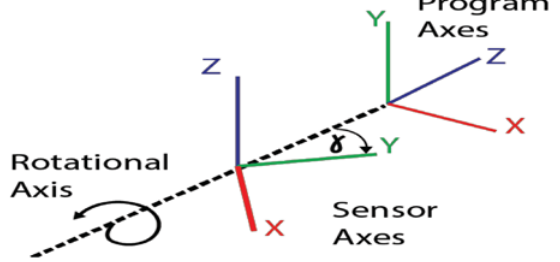
Figure 6. The rotation axis between the attention pose and T-pose in both Unity's and sensor's reference